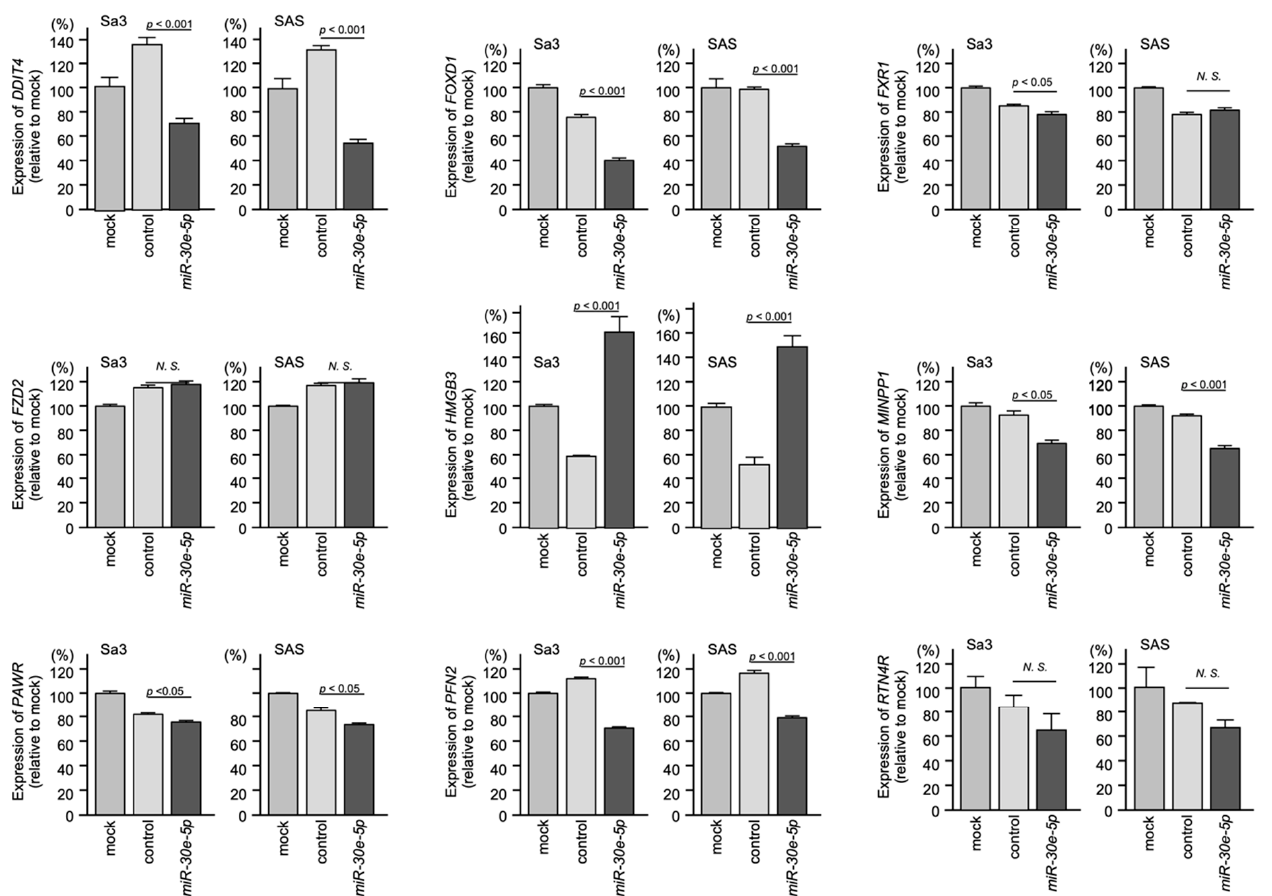
Figure 9. Regulation of the expression of nine genes by miR-30e-5p in HNSCC cells. qRT-PCR showing significantly reduced expression of FOXD1 mRNA (top, middle) 72 h after miR-30e-5p transfection in Sa3 and SAS cells (N.S.: not significant compared to control group).